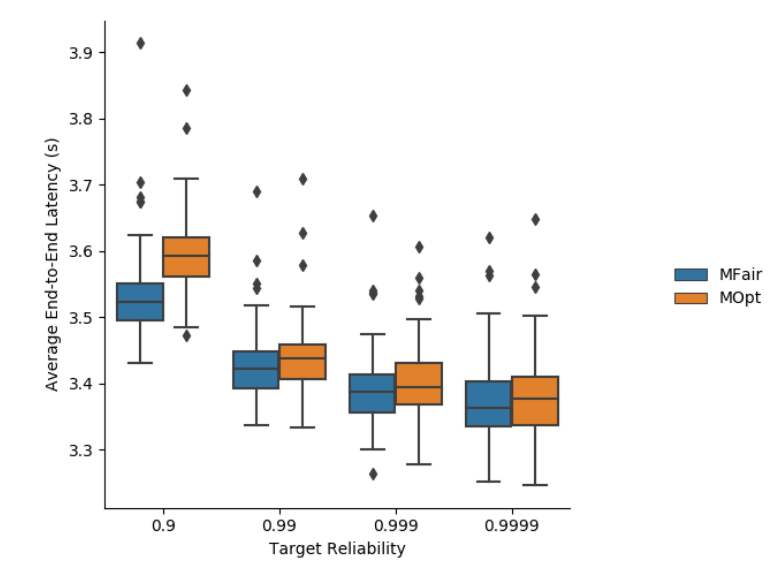
Figure 15. Average end-to-end latency obtained with MFair and MOpt for MaxTrans = 20